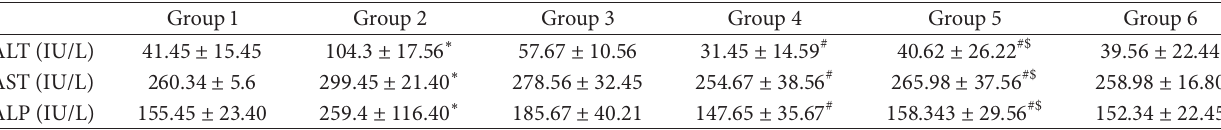
Table 5: Effect of free probiotic and encapsulated probiotic on hepatic markers in the serum of control and alcohol-administered rats.